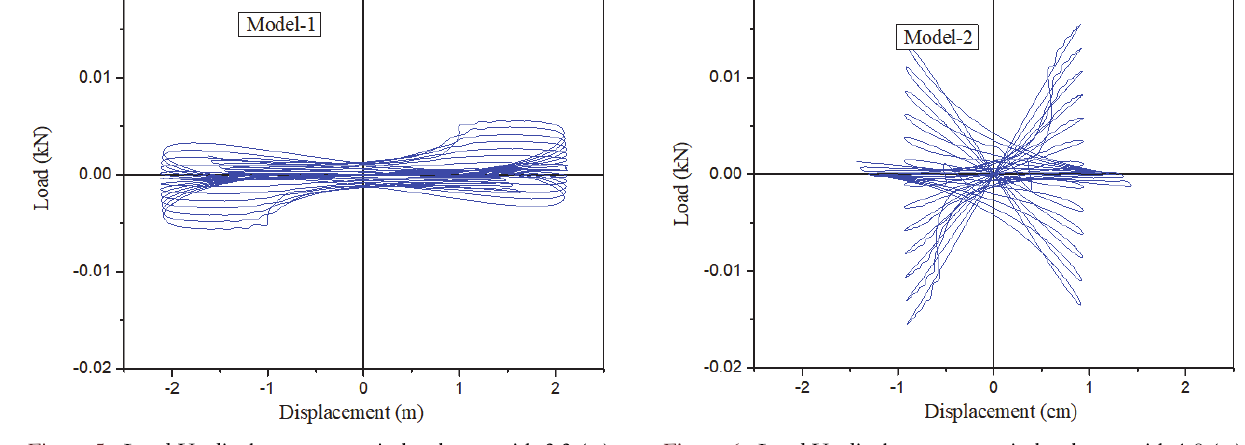
Figure 6: Load Vs displacement on timber beam with 1.8 (m) length,